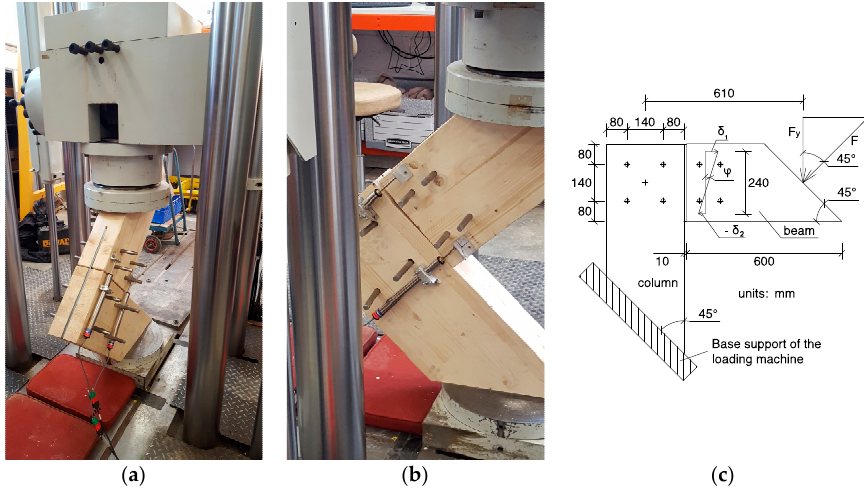
Figure 3. Experimental set-up: ( a ) machinery used for connection test; ( b ) joint under static monotonic test; and ( c ) graphic display of angular deformation.